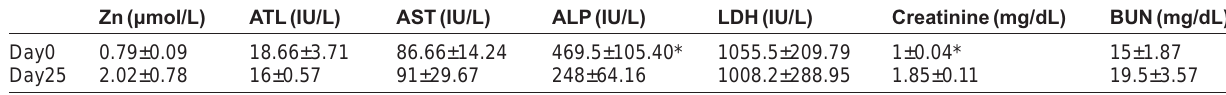
Table-1. Mean (± SE.) of serum factors in lambs under treatment (* represents significant difference between before (day0) and after (day25) treatment with p<0.05 ). Zn (µmol/L)